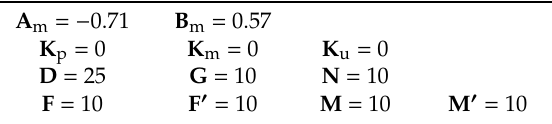
Table 4. Parameters of the reference model, control law, and adaptation mechanism for the control of the fermentation process in the laboratory batch bioreactor.